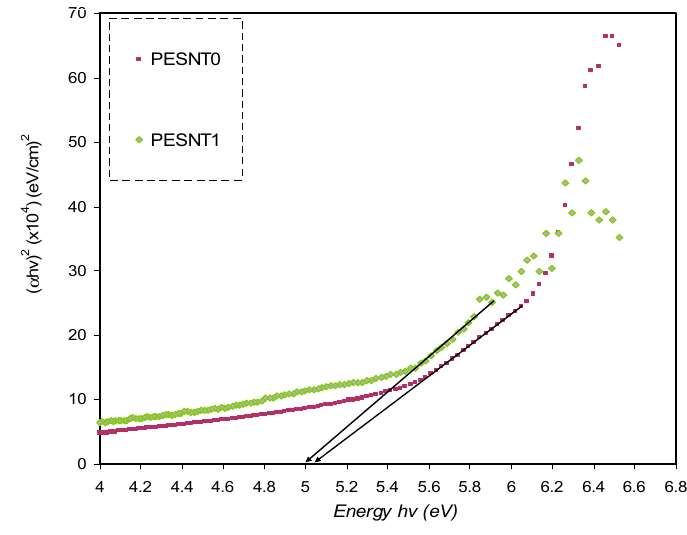
Figure 7. ( α h υ ) 2 in opposition to energy of photon for pure PEO (PESNT0) and doped (PESNT1) samples. Materials 2020 , 13 , 2979